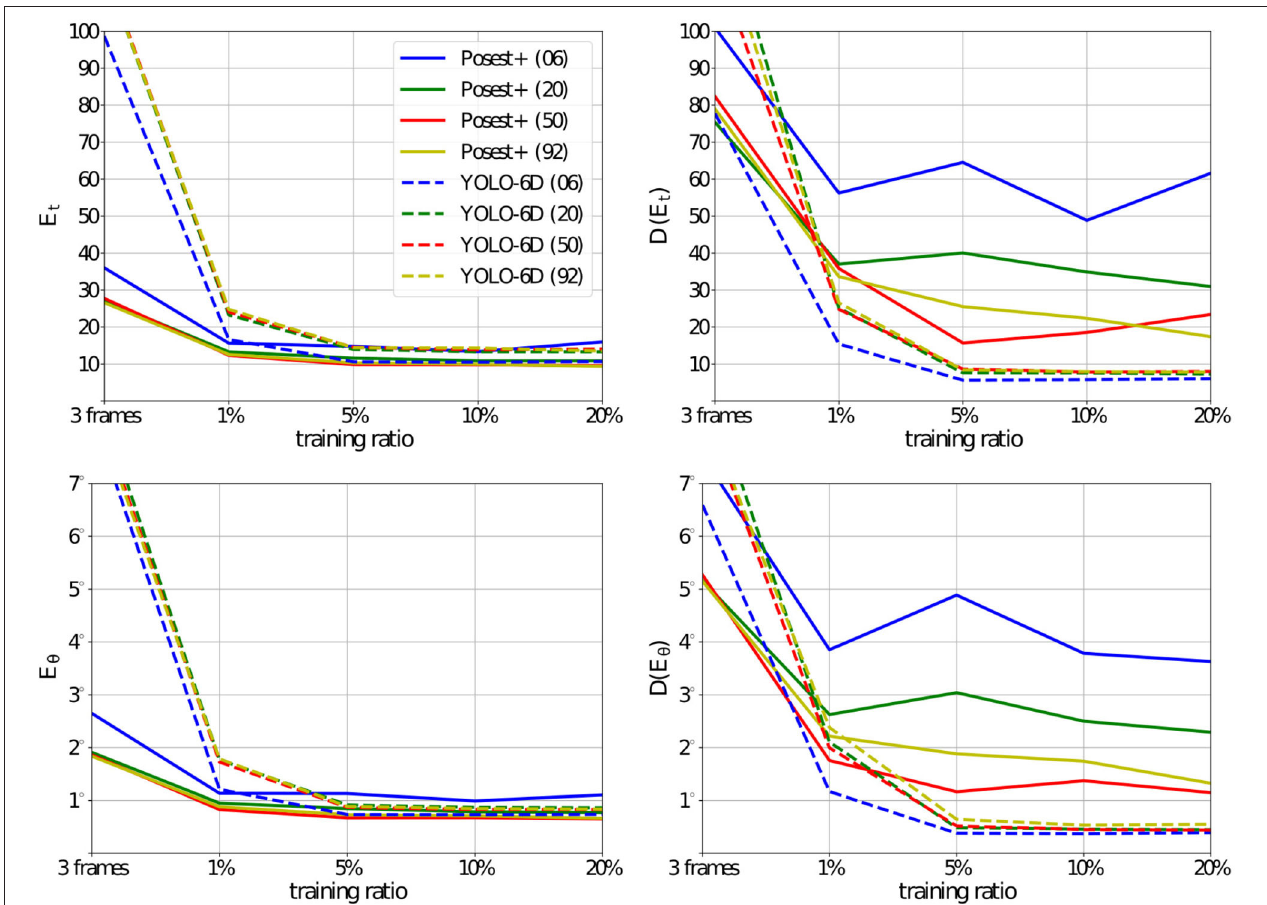
FIGURE 5 | Pose estimation error [ E t and E θ ] and standard deviations [ D ( E t ) and D ( E θ ] for the YCB92 datasets. The training set size increases on the x-axis. Each curve corresponds to experiments with the same number of classes: 6, 20, 50, and 92. Posest+ outperforms the YOLO-6D consistently for the smallest training sets. As the number of training samples increases the difference in the average errors becomes smaller. However, the standard deviation of Posest+ is much higher than that of YOLO-6D.